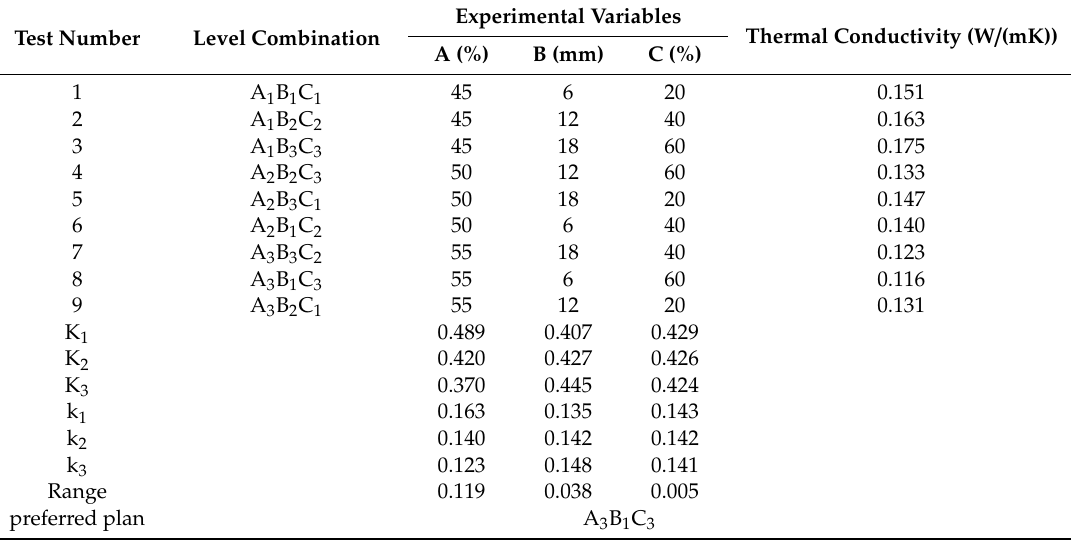
Table 6. Statistics pertaining to the thermal